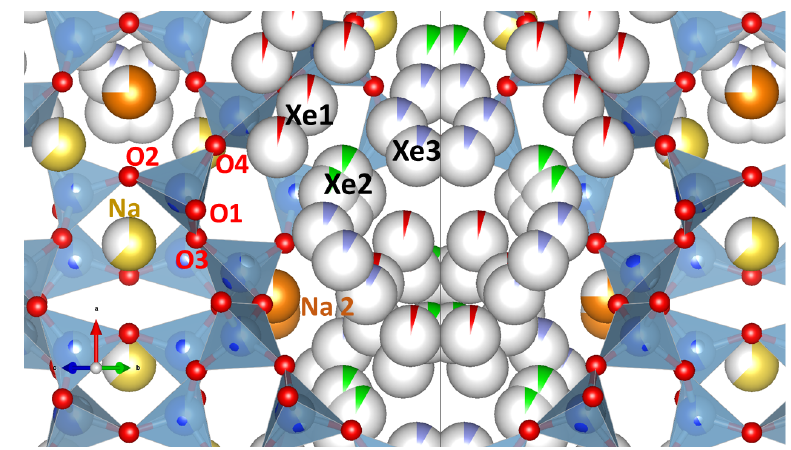
Figure 12. Y-Zeolite with Xe at 200 K with labels.